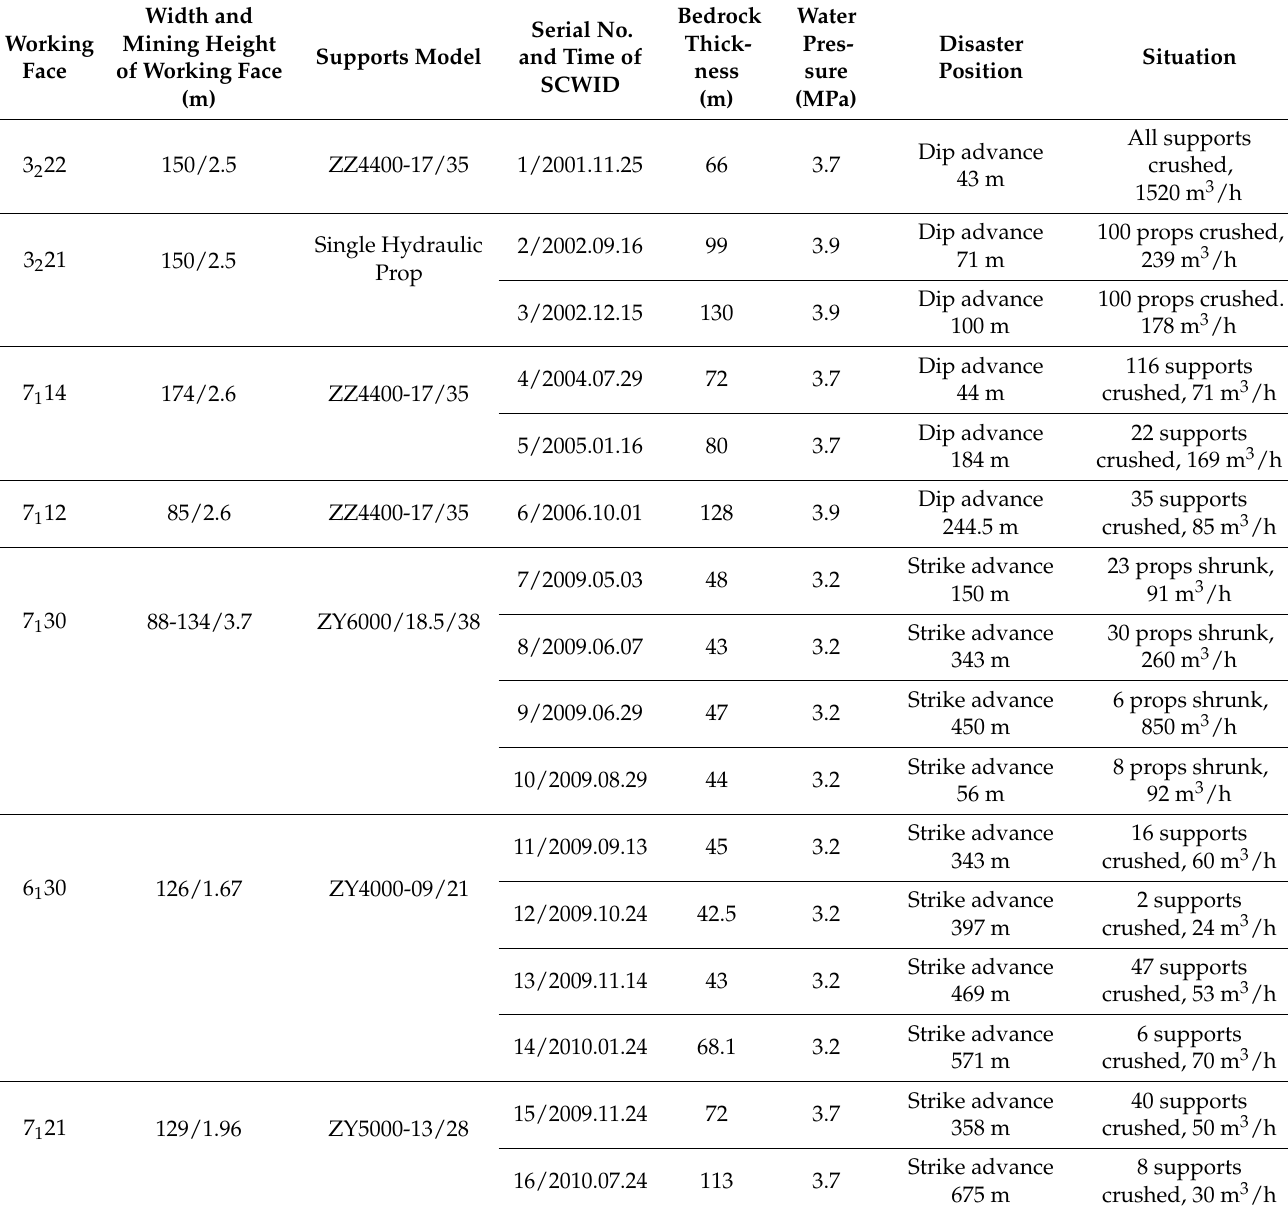
Table 1. Statistics of supports crushing and water inrush disasters (SCWIDs) in Qidong coal mines when mining under the